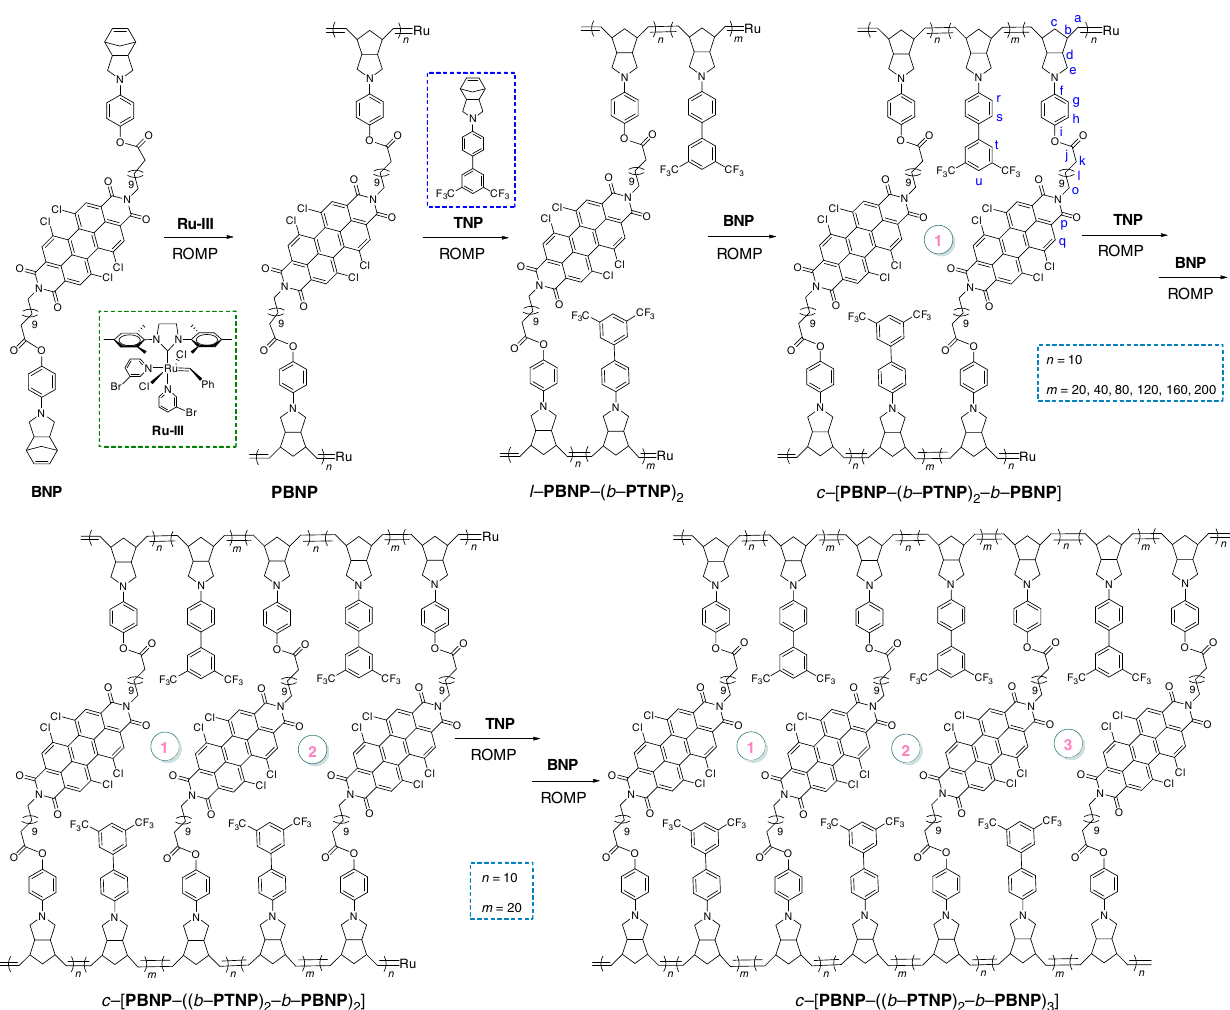
Fig. 2 Blocking-cyclization process. Syntheses of mono-, bis-, and tricyclic polymers by successive ROMP